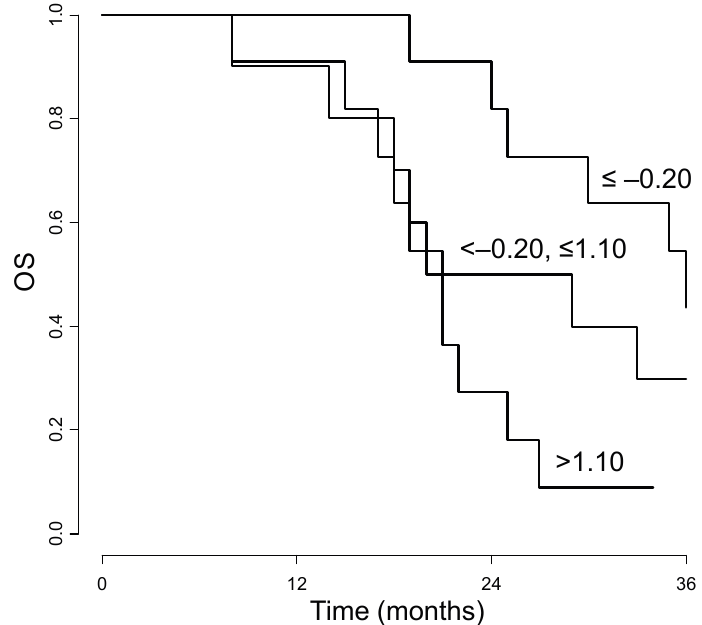
Figure 4. Kaplan-Meier overall survival curves (OS) according to CEA (log-scale) post-nadir variation. The variation was expressed as the difference between the individual levels at last follow-up and at nadir (end of first cycle); the individual differences were categorized according to tertiles (positive difference: CEA increase; negative difference: CEA